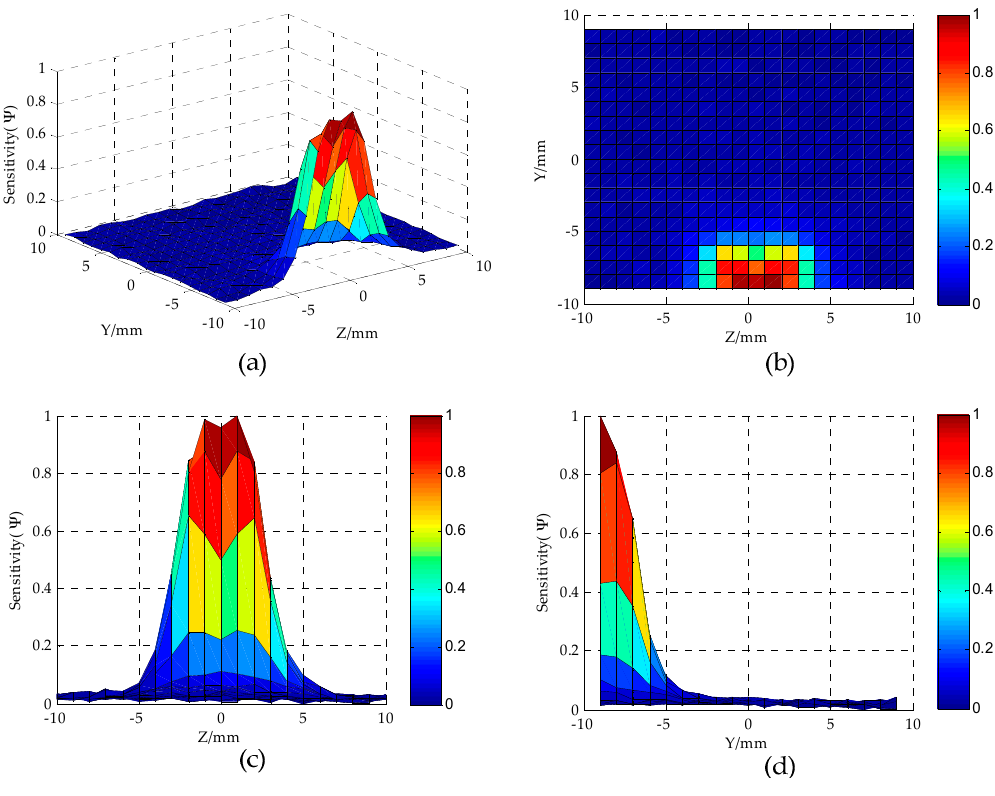
Figure 4. Sensor sensitivity distribution in YoZ plane sensitive field ( D = 20 mm, h = 3 mm, d = 1.5 mm, S = 4 mm): ( a , b ) YoZ plane regions; ( c ) Z-axis direction; ( d ) Y-axis direction. Table 1. Sensitivity field parameters of MCP with different grids ( D = 20 mm, h = 3 mm, d = 1.5 mm, S = 4 mm).